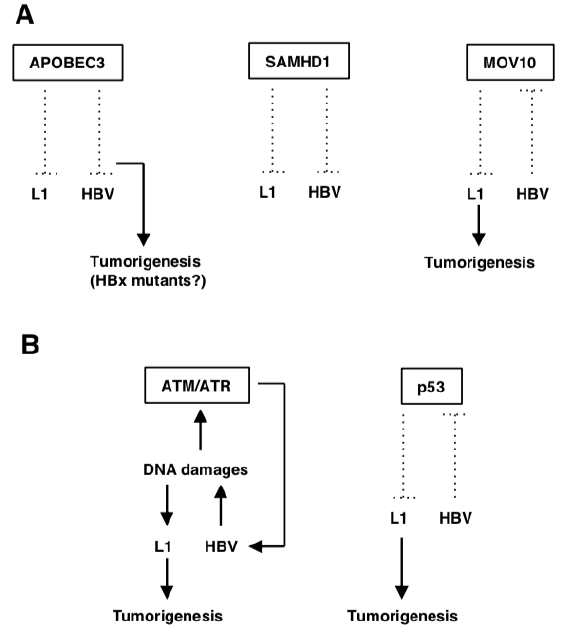
Figure 1. L1-related genes in HBV-related HCC. ( A ) Host defense genes against L1. APOBEC3s